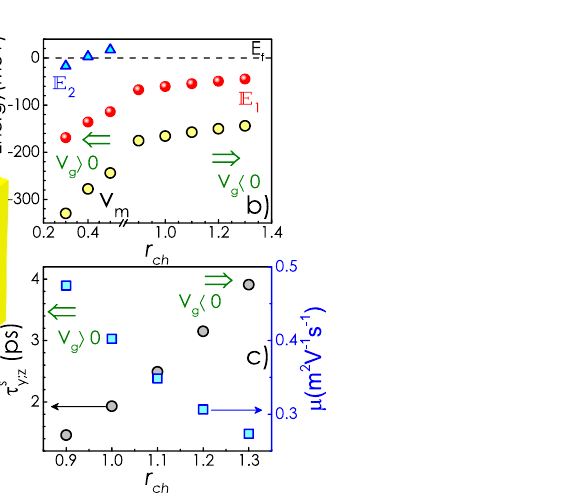
Figure 3. ( a ) Variation of momentum relaxation time ( τ m ), mobility ( µ ), ( b ) relaxation time for y and z component of spin( τ s y , z ) and corresponding spin coherence length ( L s ) as a function of N d . All the calculations are carried out at T = 10 K.